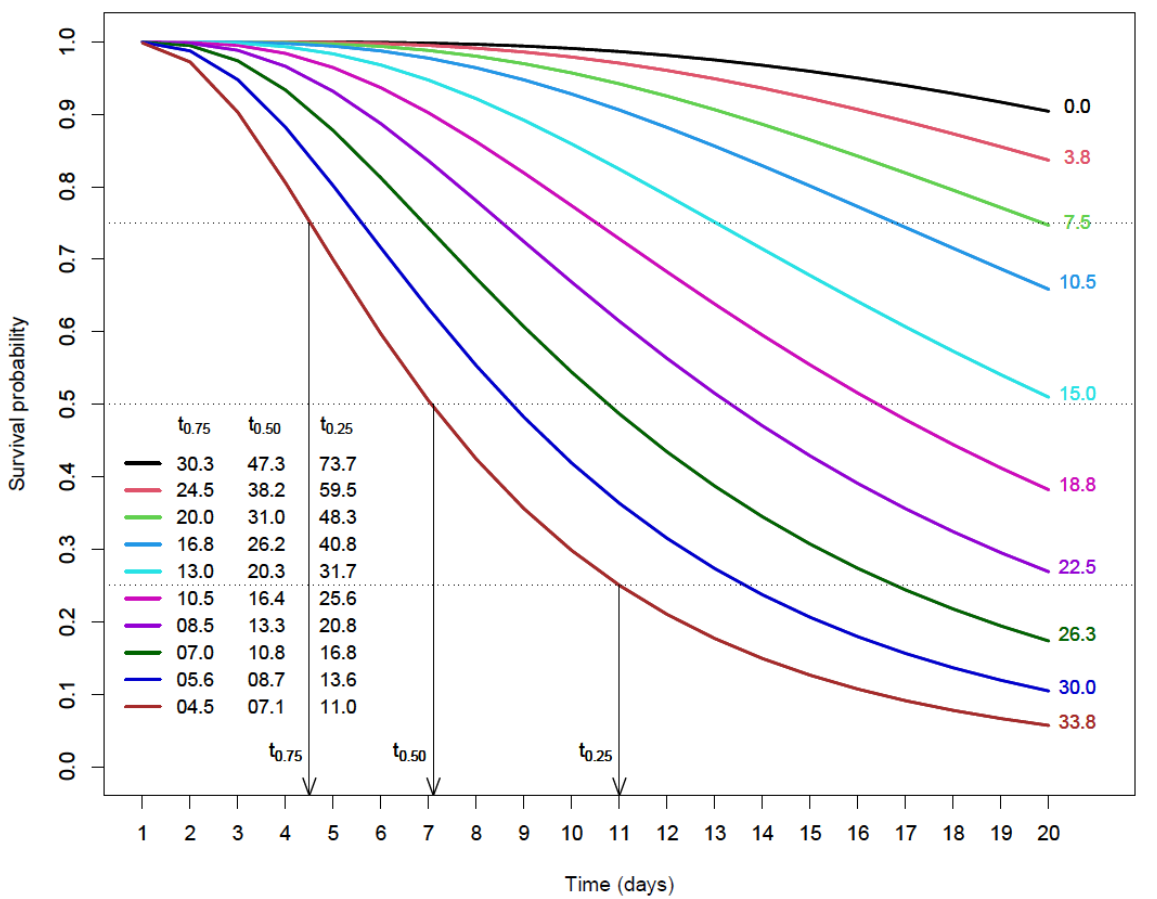
Figure 4. Survival curves estimated by the Log-normal model for Chrysoperla externa exposed to different doses (mg a.i. L − 1 ) in Natuneem ® . The times for 75%, 50%, and 25% of the individuals to be alive are also presented.